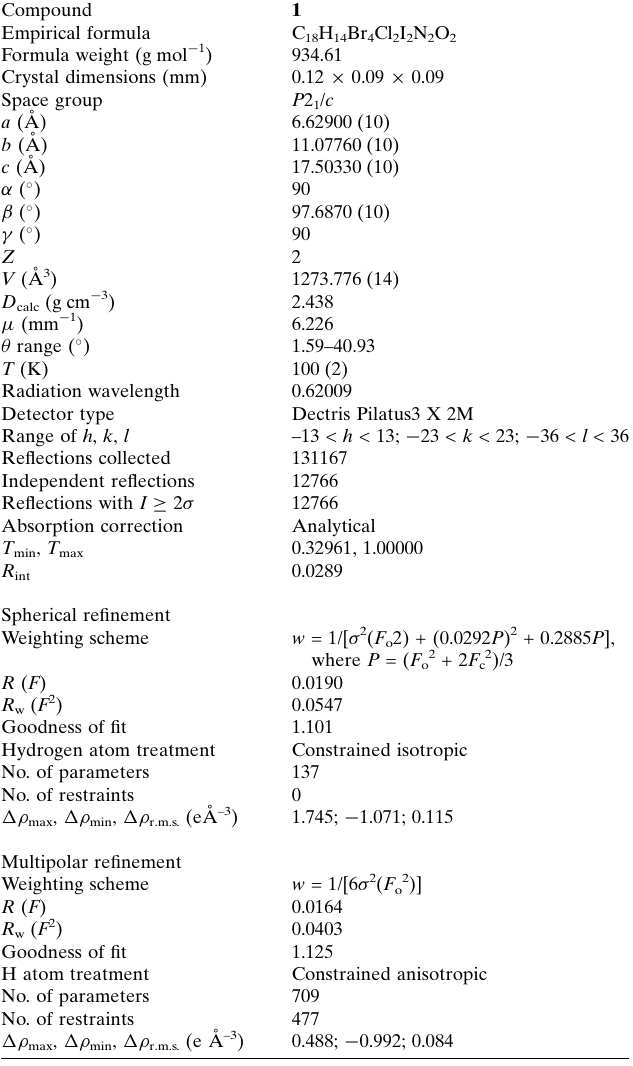
Table 5 Crystallographic data collection and charge-density refinement